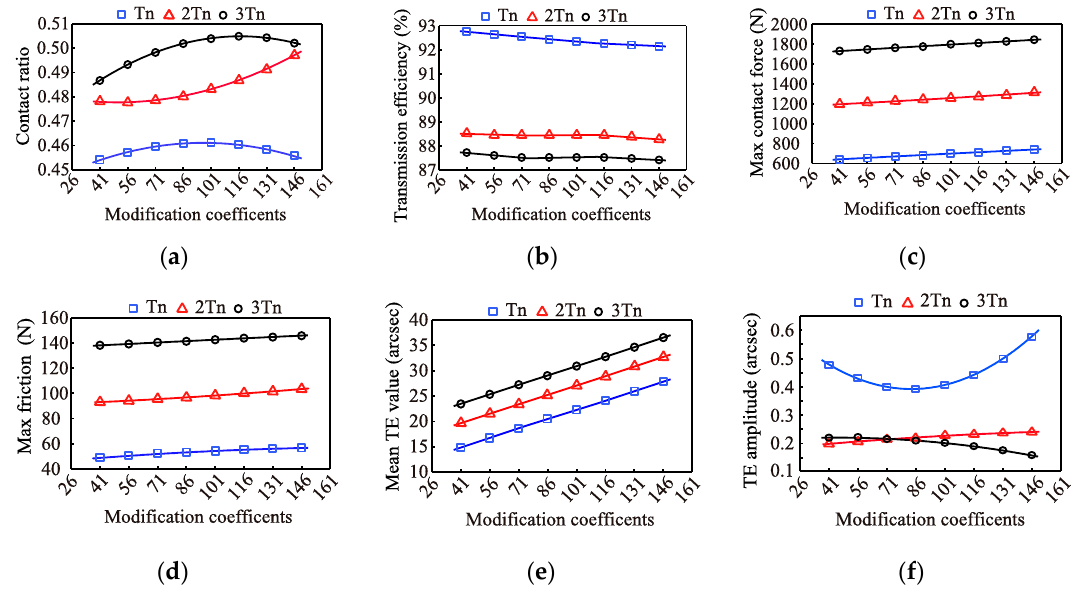
Figure 14. Effect of case 3 modification method on the transmission performance of RV reducer: ( a ) contact ratio, ( b ) transmission efficiency, ( c ) max contact force, ( d ) max friction, ( e ) mean TE value, and ( f ) TE amplitude.